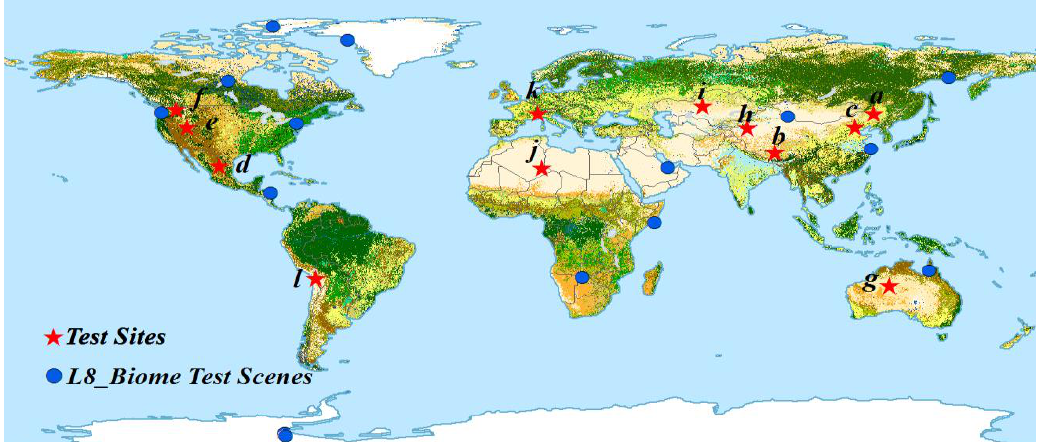
Figure 1. Spatial distribution of the 12 test sites and the 14 L8_Biome Landsat-8 test scenes. The background map is the 300 m Global Land Cover Map (GlobCover 2009) [39]. Noted: L8_Biome Test Scenes refers to the Landsat-8 test images selected from the Landsat 8 Cloud Cover Assessment Validation Dataset.